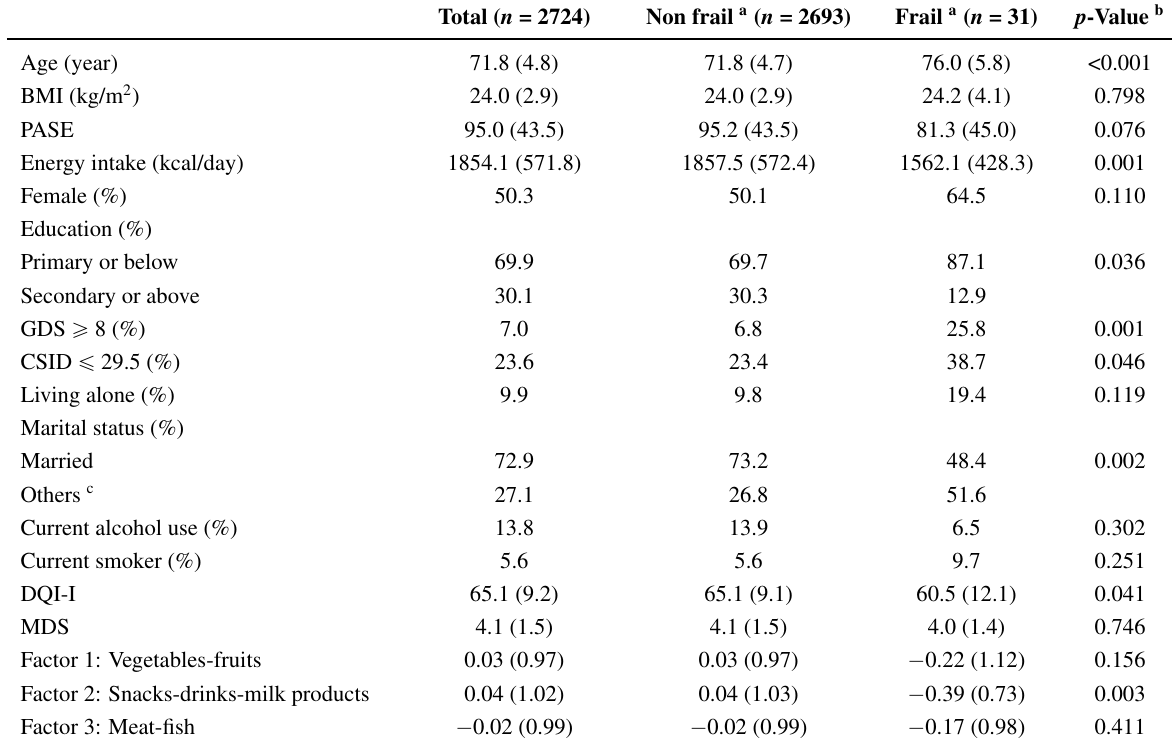
Table 2. Baseline characteristics of participants by four-year frailty status ( n = 2724). Total ( n = 2724) Non frail a ( n = 2693) Frail a ( n =